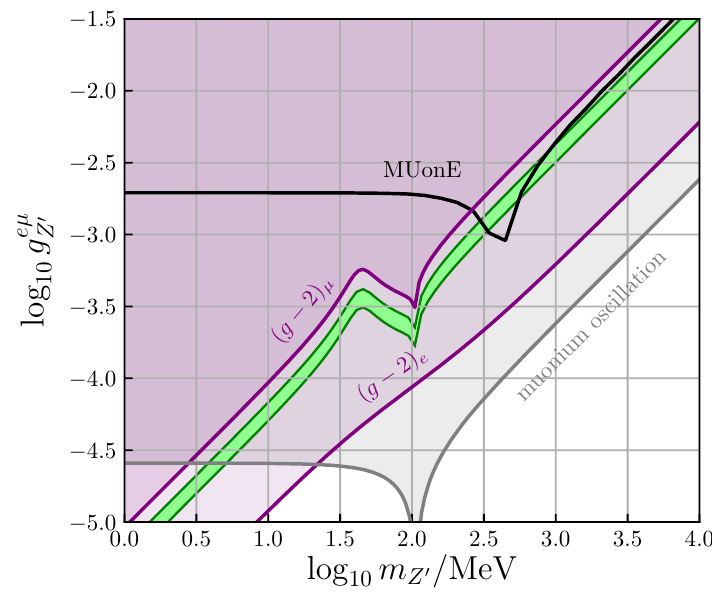
Figure 6 . Constraints on the tree-level s -channel Z 0 . The gray-shaded region is the muonium- antimuonium oscillation limit. The rest of the color coding is the same as in (cid:12)gure